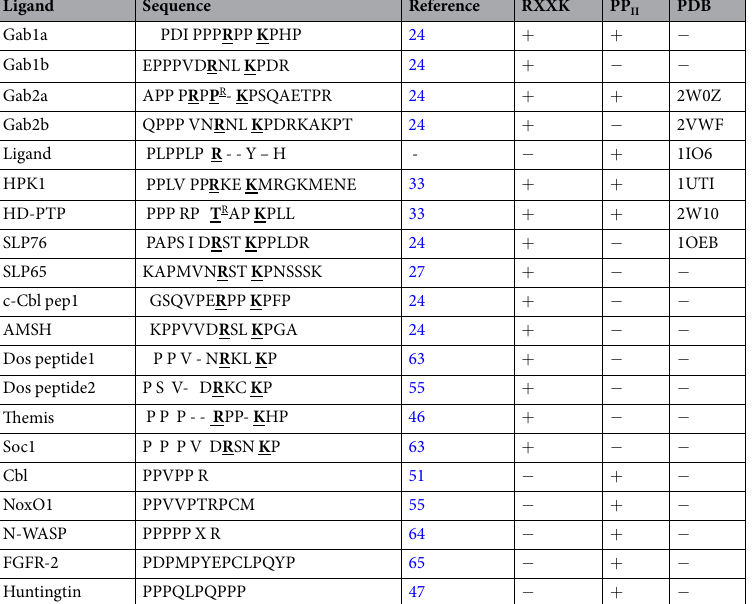
Table 3. Peptides from different signaling proteins known to bind Grb2/Mona Gads SH3C. The peptides have an RXXK motif, or a polyproline helix motif, or both. R XX K motif has been underlined and shown in bold. Superscript R indicates the spatial position of the R side chain in the crystal